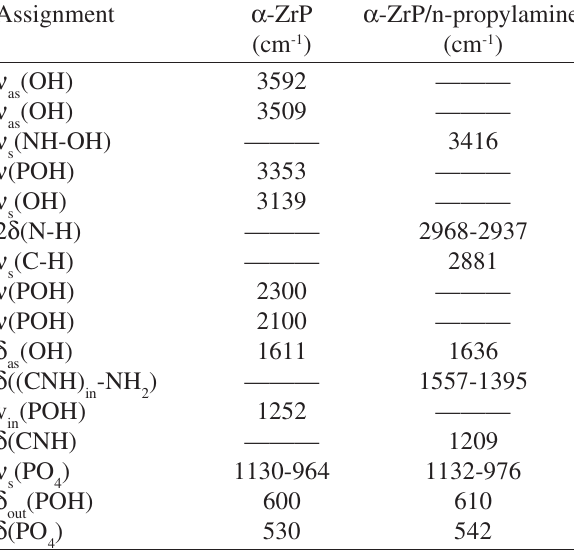
Table 1. Bands attributions in FTIR spectra of alpha-zirconium phosphate and zirconium phosphate exfoliated with n-propylamine dried at 50 °C.